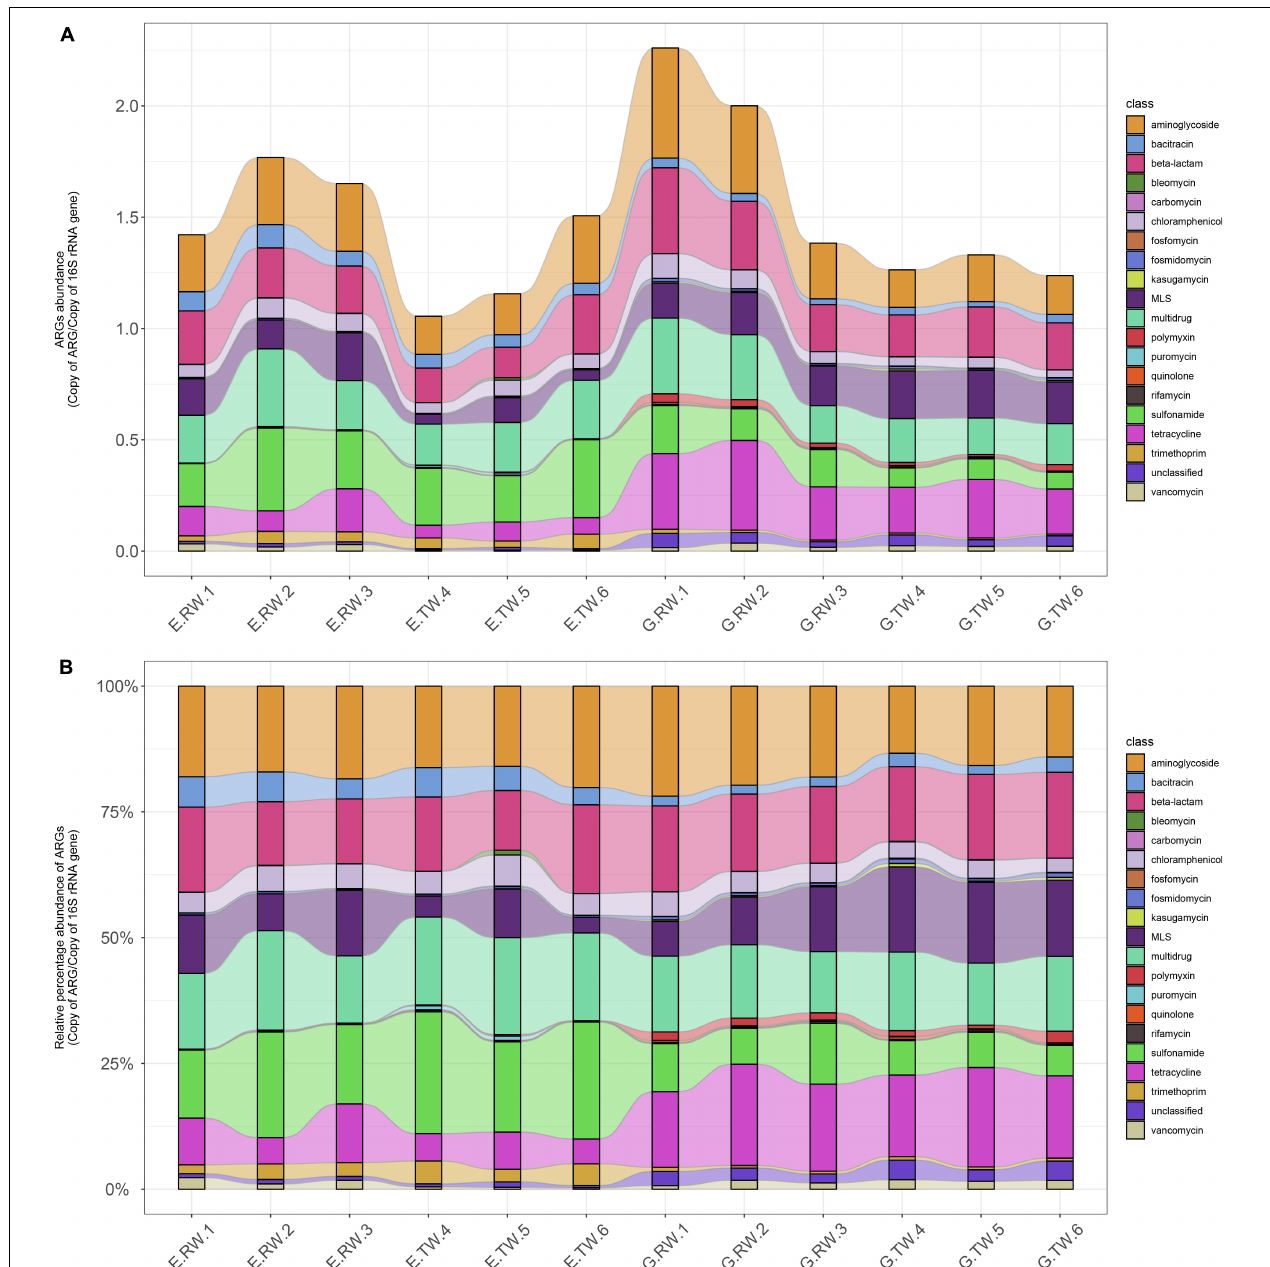
FIGURE 5 | ARGs abundance in each sample. (A) Abundance of ARG types in each sample (ARGs copies per copy of 16S rRNA gene). (B) Relative percentage of the ARG types in each sample with the total abundance normalized to